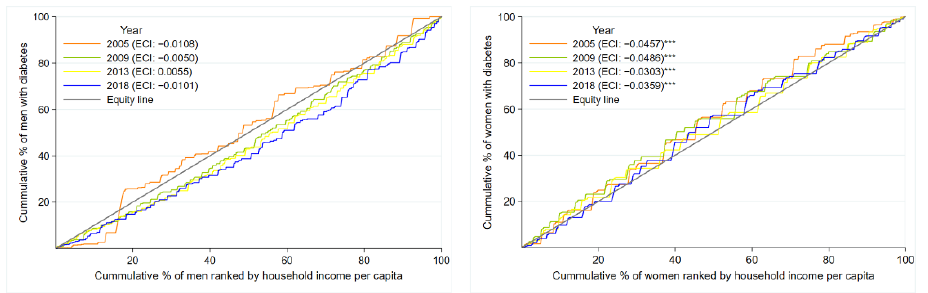
Figure 3. Concentration curves and the Erreygers concentration indices for diabetes prevalence according to sex. ECI: Erreygers concentration index. Test to compare 2005 ECI vs 2018 ECI: p = 0.9681 for men and p = 0.4754 for women. Significance level for ECI: *** = 0.01.